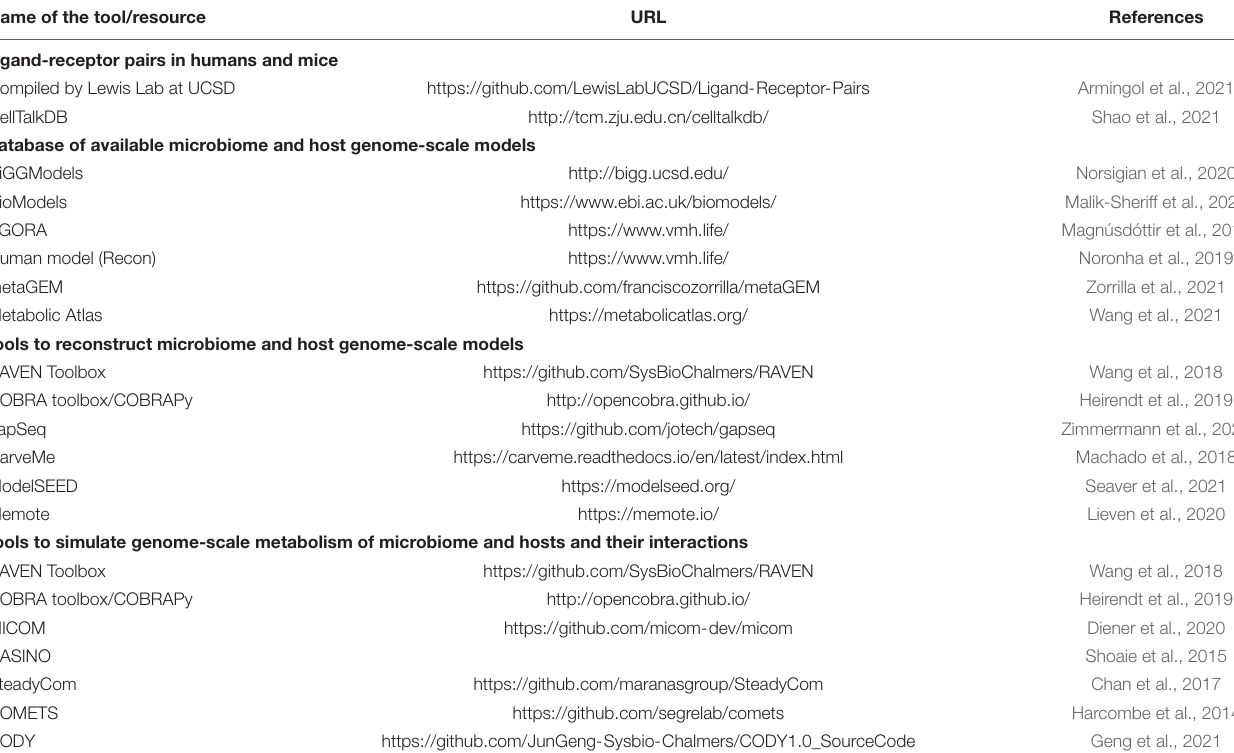
TABLE 1 | Survey of systems biology tools and resources to study gut microbiome-host receptor interactions. Name of the tool/resource